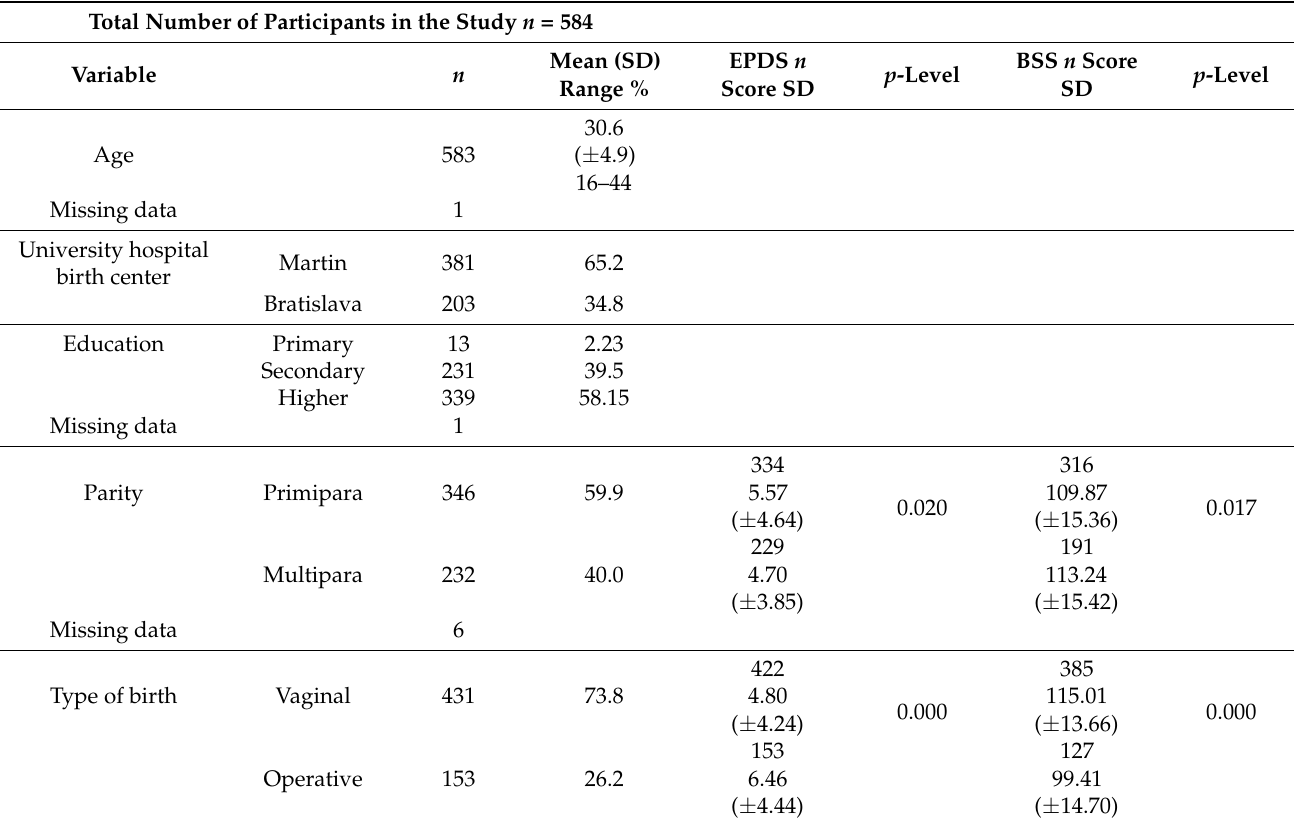
Table 1. Characteristics of participants and mean EPDS and BSS scores in different groups (Parity, Type of birth, Psychiatric history). Total Number of Participants in the Study n = 584